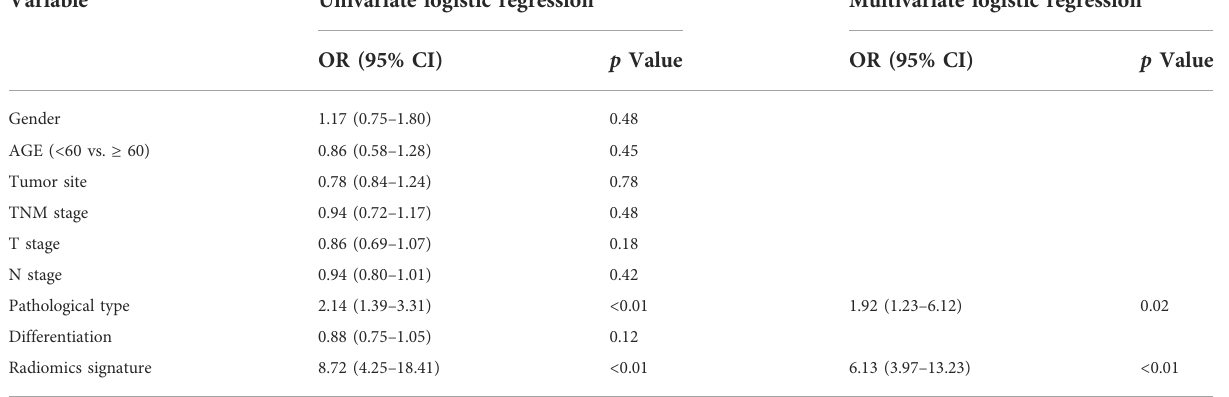
TABLE 2 Risk factors of HER2 overexpression in advanced gastric